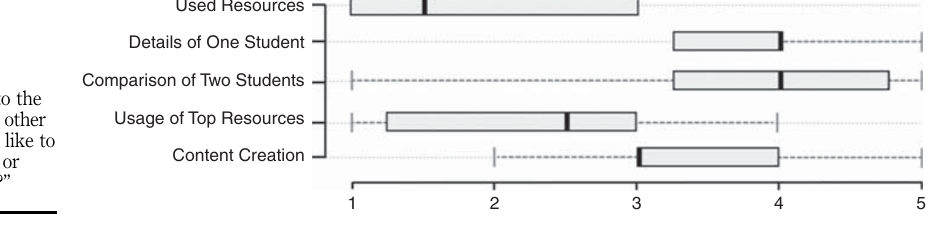
Figure 5. Frequency